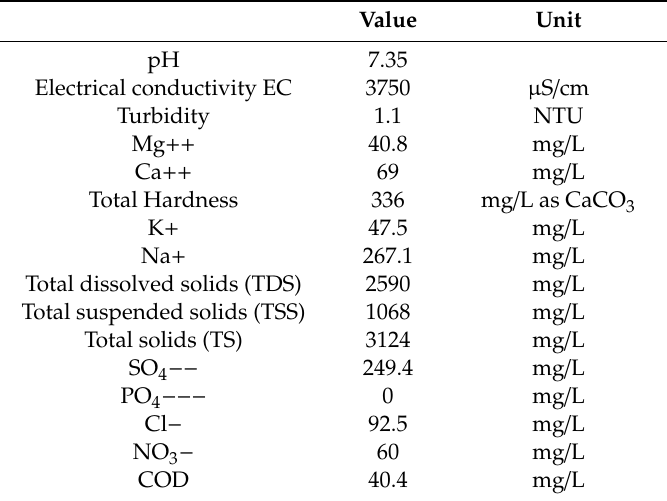
Table 1. Water specification